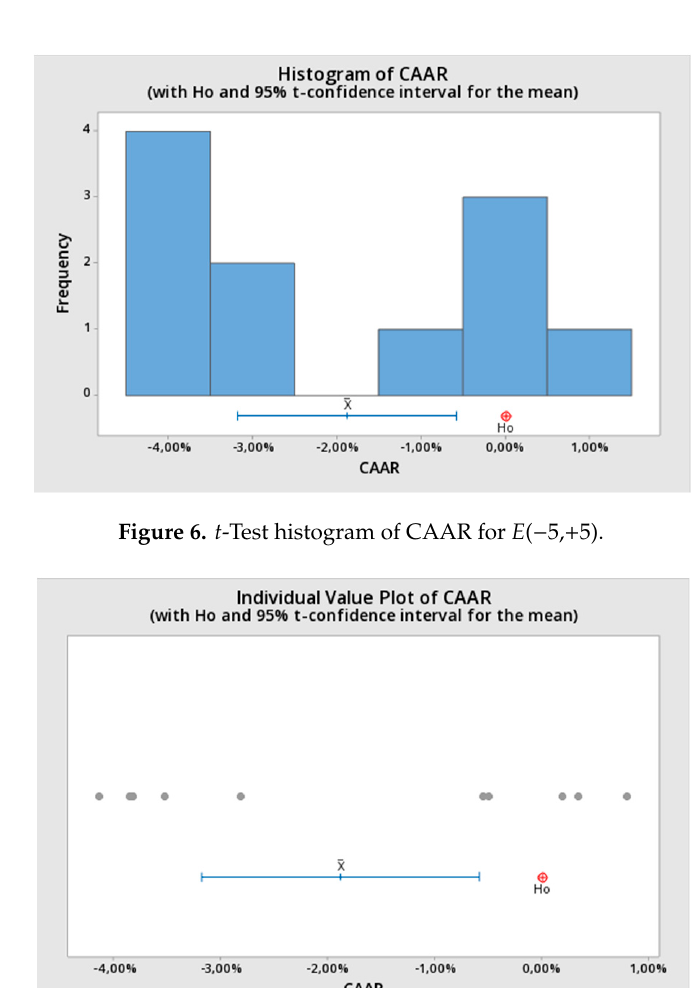
Figure 5. t -Test P-P plot of CAAR for E ( − 20,+20) .